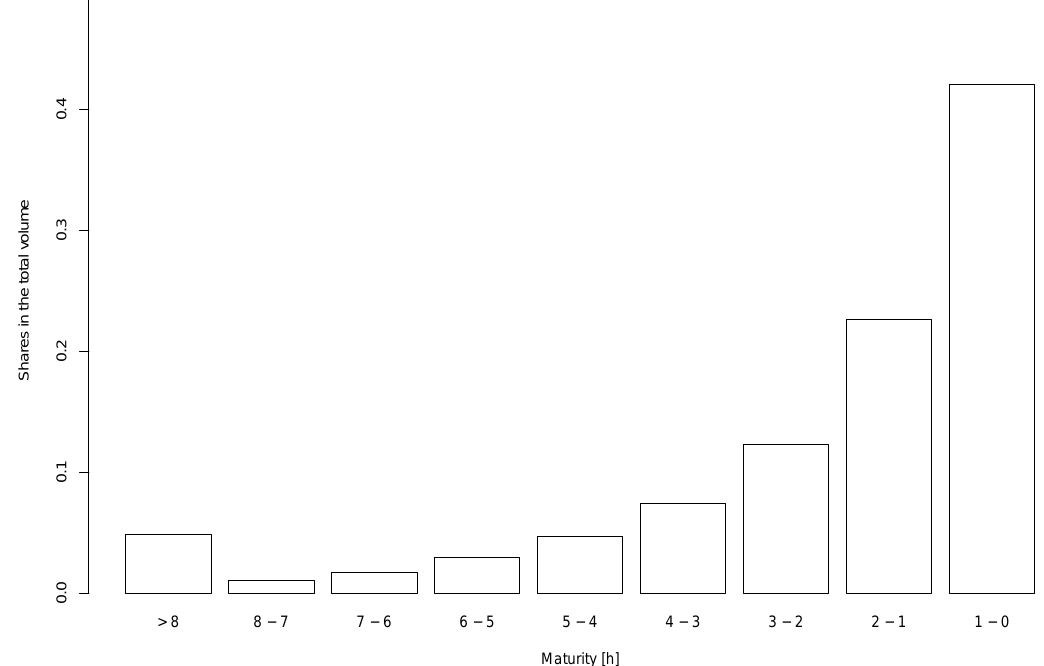
Figure 3. Relative trading volume of the continuous intraday market per hour before maturity (up to 30 min before delivery). The figure illustrates that trading volume increases sharply with decreasing time to